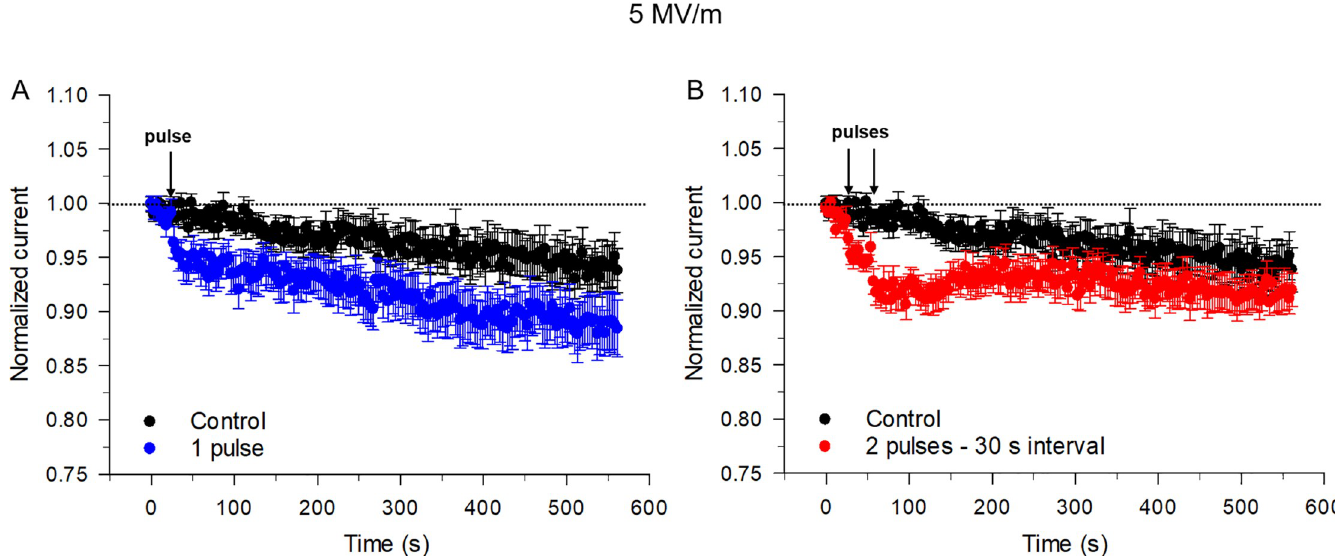
Fig 2. Effects on I Na of a single or twin NEP applied at an E-field of 5 MV/m. (A) Time course of changes in I Na for unexposed cells (control, black circles) compared to cells exposed to a single NEP (1 pulse, blue circles). (B) Time course of changes of I Na in cells exposed to a twin pulse applied with a 30 s interpulse interval (red circles) compared to that recorded in unexposed cells (control, black circles). For both panels, normalized current represents the magnitude of peak inward current evoked by the constant voltage step protocol described in the Methods normalized to the mean peak inward current recorded during the 8 voltage clamp steps to +10 mV (holding potential = –70 mV) that preceded the NEP(s). Each data point is a mean ± SE (control, n = 20; 1 pulse, n = 12; twin pulse, n = 10).